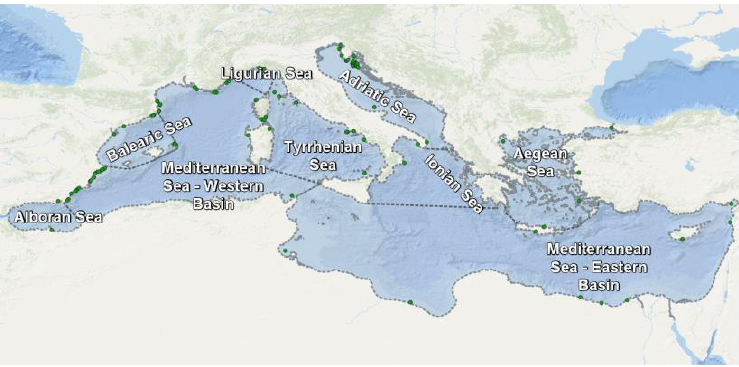
Figure 6. Spatial distribution of Zosteraceae in the Mediterranean Sea (UNEP-WCMC database).